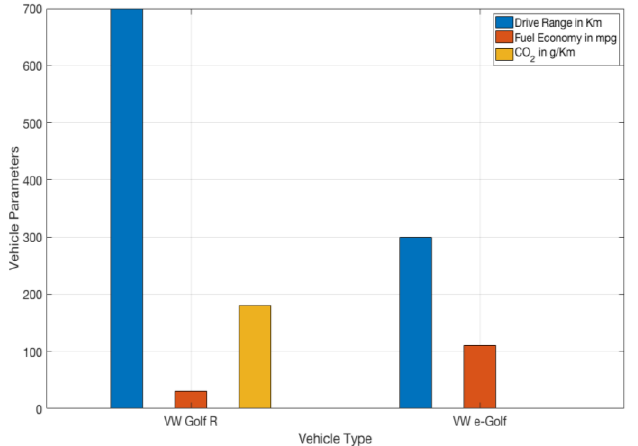
Figure 6. Different vehicle parameters comparison of an internal combustion engine and an electric vehicle from the same manufacturer (Volkswagen (VW)).